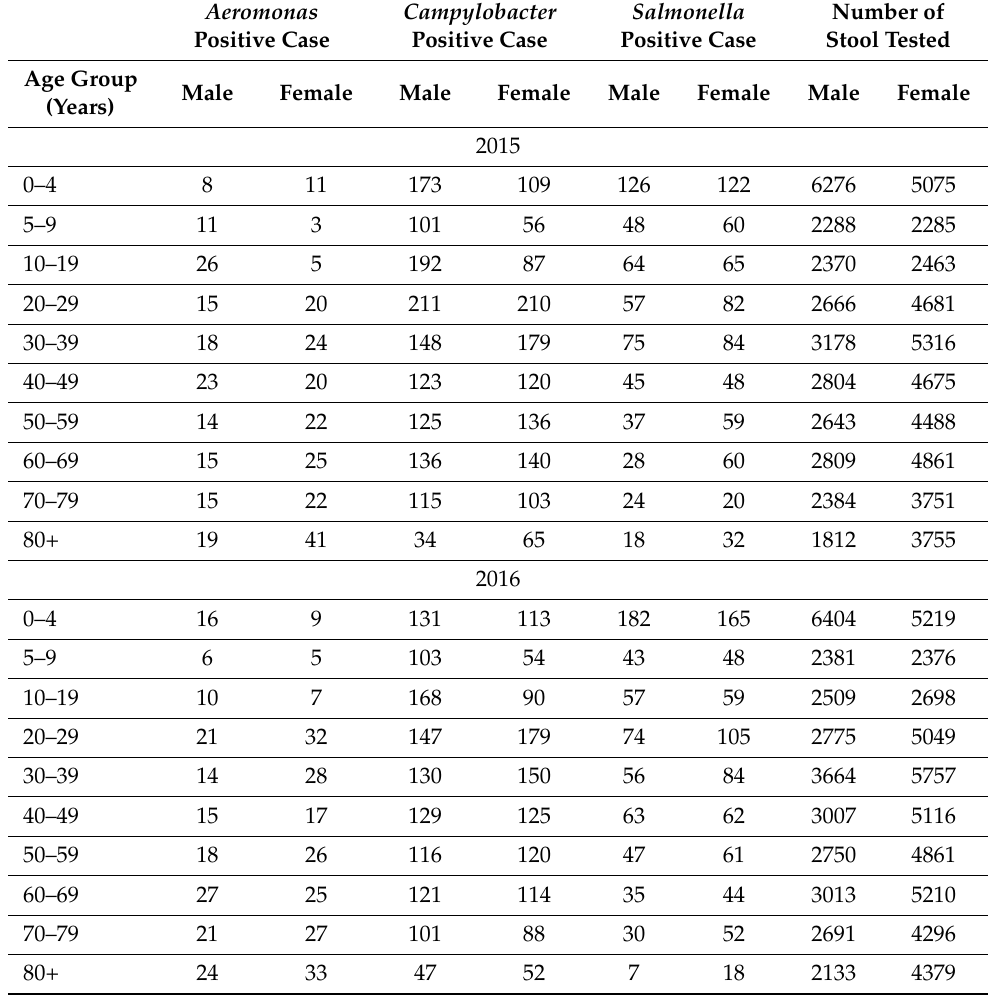
Table 3. Isolation of Aeromonas , Campylobacter and Salmonella species in individual years, from 2015 to 2019, in different age